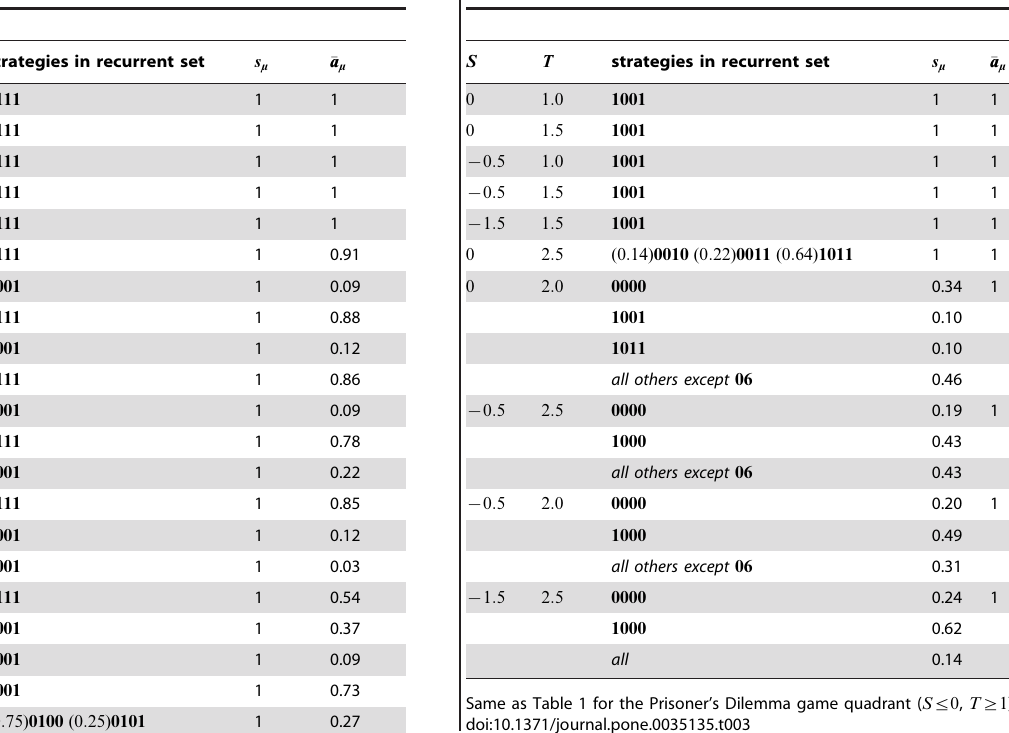
Table 2. Recurrent sets found in the Harmony game quadrant.